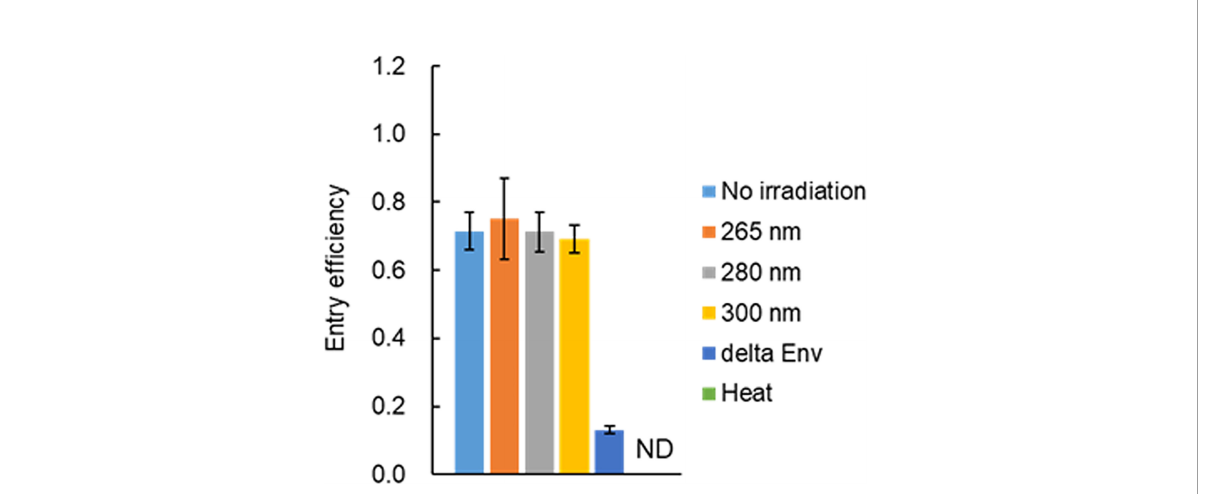
FIGURE 4 Effect of UV-irradiation on the viral entry process. Viruses were prepared from HEK293T cells transfected with proviral clones pNL4-3 (WT) or pNL-Kp (delta Env). Virus stocks were diluted with PBS containing 2% FBS, and exposed to UV at three wavelengths with various power densities (0.47 mW/cm 2 for 265 nm, 0.73 mW/cm 2 for 280 nm, 1.50 mW/cm 2 for 300 nm) for 160 sec. Heat-treated WT virus stocks were also prepared and diluted in the same manner as UV-irradiated samples. The diluted UV- or heat-treated samples were used for the entry assay. The assays were carried out as described in “ Materials and Methods ” (Entry assay). The entry ef fi ciency of each sample, calculated as the p24 level of entry fraction/p24 level of the binding fraction, is presented. Mean values with SE are shown (n=3). The control heat-treated virus sample did not bind to cells and thus the entry ef fi ciency was not determined. ND, not determined.